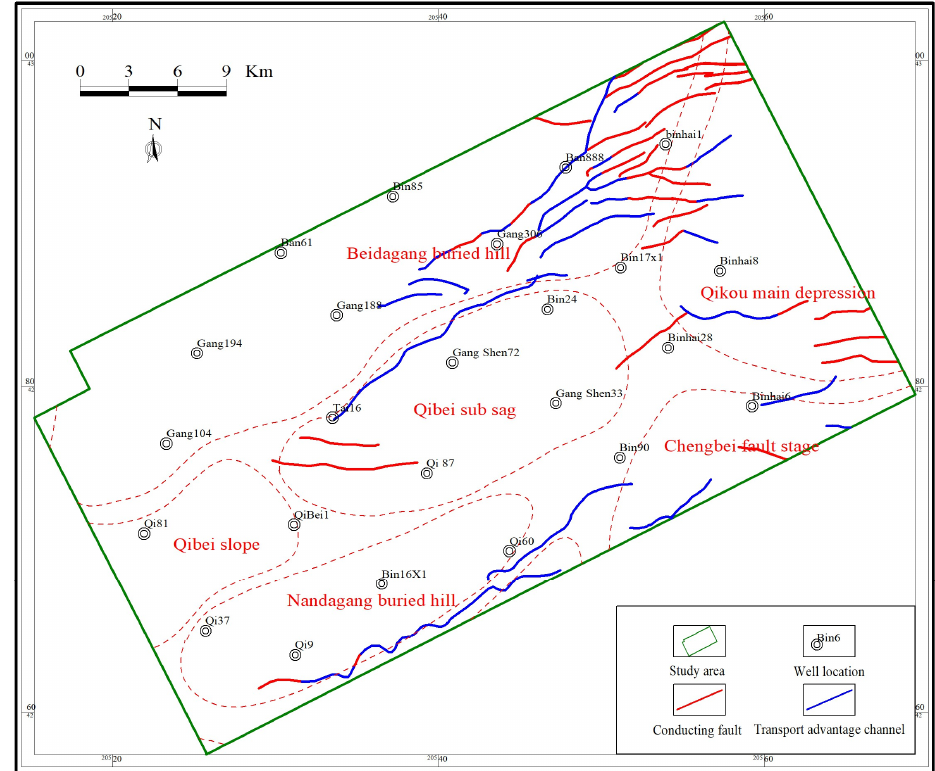
Figure 8. Distribution of the predominant pathways in fault systems at the Ed-3 Member in the south of the northern Dagang area.